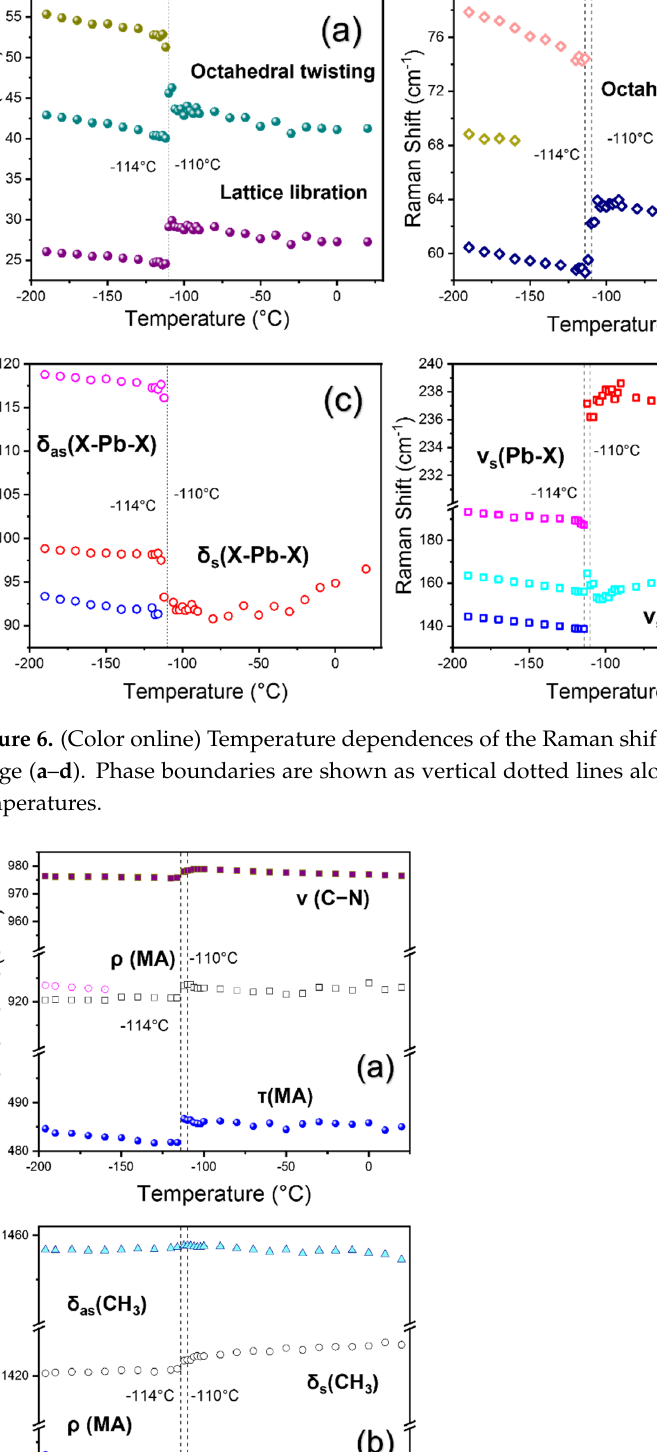
Figure 7. (Color online) Temperature dependences of the Raman shift in a 400–1700 cm − 1 frequency range ( a – c ). Phase boundaries are shown as vertical dotted lines along with the phase transition temperatures. The FWHMs of these modes, which are shown in Figure S1 in the Supplementary Materials, also display clear anomalies at the two transition temperatures. The FWHMs are very low in the orthorhombic phase while they become much larger in the high ‐ tem ‐ perature cubic phase. This indicates that the ordered arrangement of MA cations in the orthorhombic phase is responsible for weak anharmonicity and the low damping of optic phonons. A recent Raman study revealed that the MA cations are ordered along a specific crystallographic direction in the orthorhombic phase [34]. On the other hand, the C–N axis of the MA cations is disordered along equivalent <110> directions in the cubic phase [21]. Free rotating dynamics of MA cations in the cubic phase induce strong anharmonic lattice interactions causing the phonon damping larger, as indeed seen in the FWHM data. Some modes show strong broadening upon heating until they disappear at a particular transi ‐ tion temperature. For instance, the mode at 77 cm − 1 (octahedra distortion mode) first